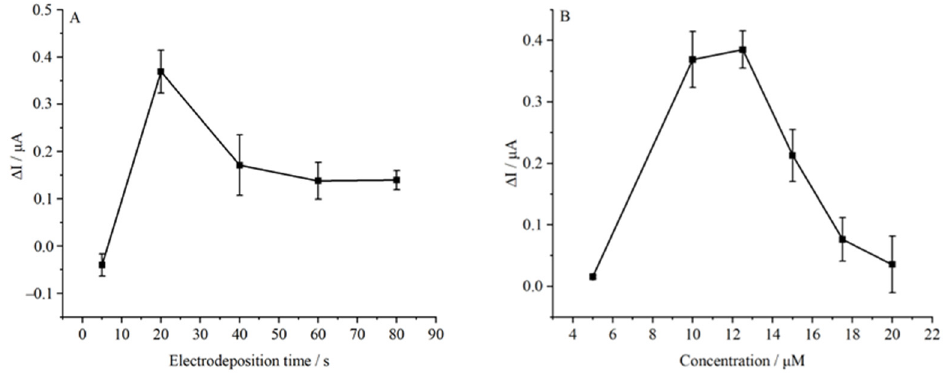
Figure 2. Effects of electrodeposition time of CS–GO ( A ) and the concentration of aptamer ( B ) on DPV response of IIP-aptamer-Pb(II) toward 1 µ g/mL Pb(II) in 0.1 M phosphate the DPV response of IIP-aptamer-Pb (II) toward 1 μ g/mL Pb (II) in 0.1 M phosphate buffer.